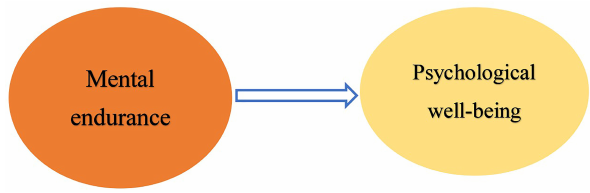
Fig. 1. Conceptual model of research. H 1 : Mental endurance significantly affects psychological well-being in a positive way. H 2 : Mental endurance significantly affects psychological well- being in a negative